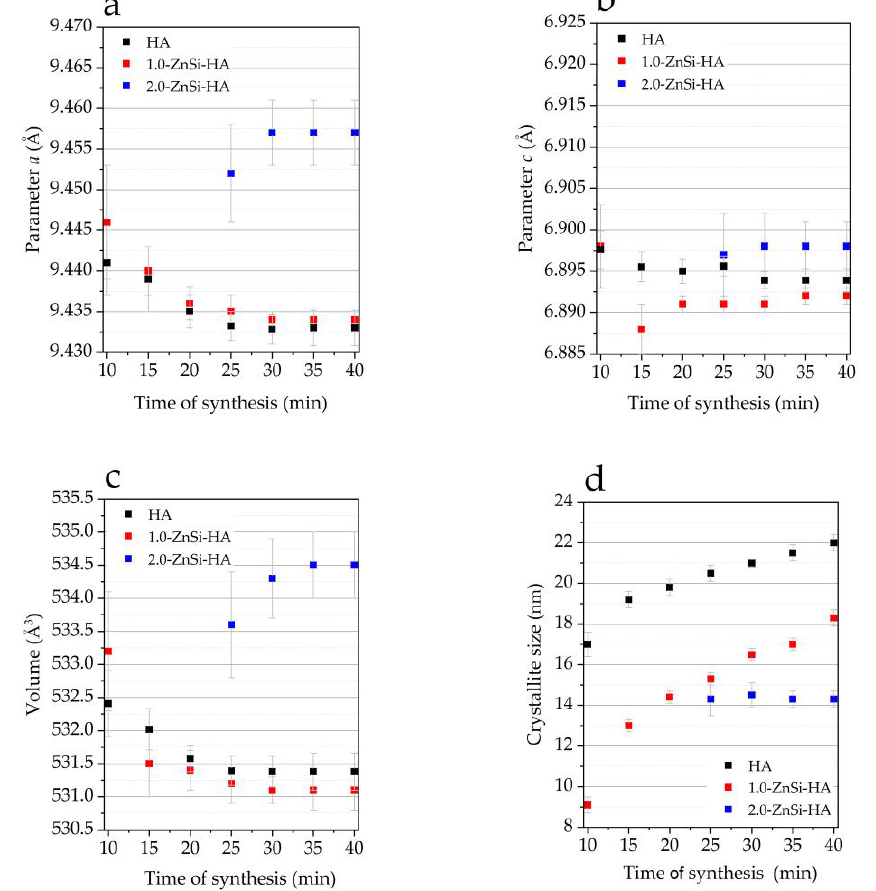
Figure 2. Evolution of lattice parameters ( a , b ), volume ( c ), and crystallite size ( d ) of HA phase during synthesis of samples with different dopant concentration.